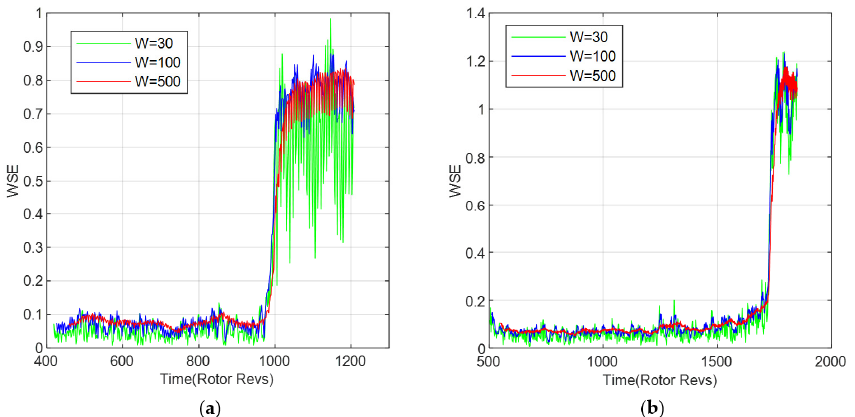
Figure 4. The effect of sliding window width selection on wavelet singular spectral entropy: ( a ) Wavelet singular spectral entropy at 2500 rpm; ( b ) Wavelet singular spectral entropy at 3000